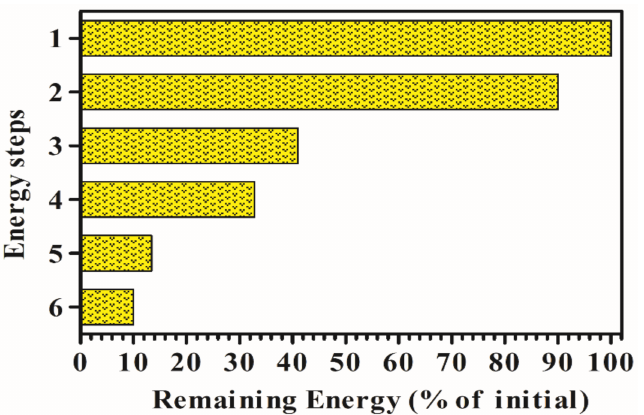
Figure 4. The energy losses of the incident solar light during the different steps of the photobiological H 2 production